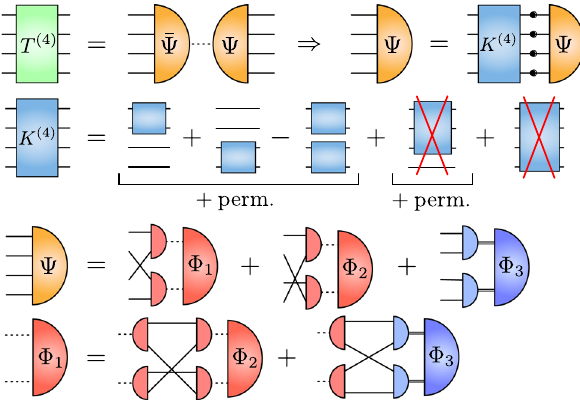
Fig. 1 Diagrammatic representation of the basic quantities used in deriving the pure two-body/four-quark BSE. In the first line we display the representation of the bound state together with its corresponding BSE (4). In the second line we give the explicit decomposition of the interaction kernel K ( 4 ) in terms of irreducible two-, three- and four- body interactions. The red crosses indicate truncations, justified and explained in the main text. The third line displays the reduction of the four-body amplitude into a sum of two-body amplitudes featuring inter- nal mesons (dashed lines) and (anti-)diquarks (double lines). One of the resulting effective two-body equations is given in the lowest line. The other two equations are obtained under permutations in the index set { 1 , 2 , 3 } , thus spanning the whole coupled system of two-body BSEs (for equal quark masses (cid:4) 1 and (cid:4) 2 are